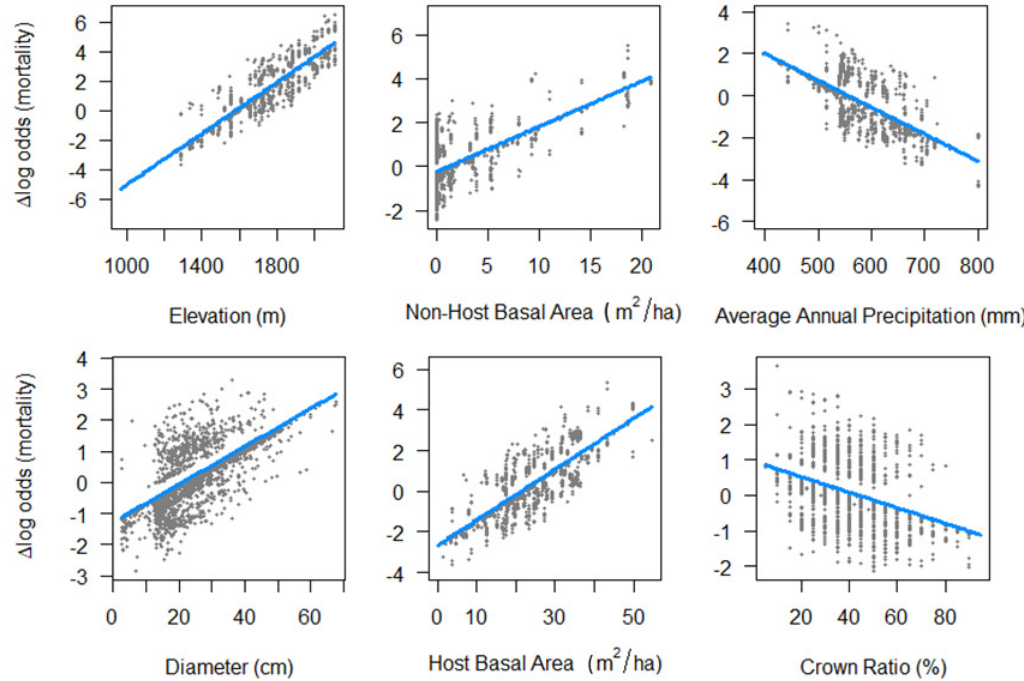
Figure 2. Raw mortality rates observed during the study. Sample sizes (individual trees) are denoted above each bar.